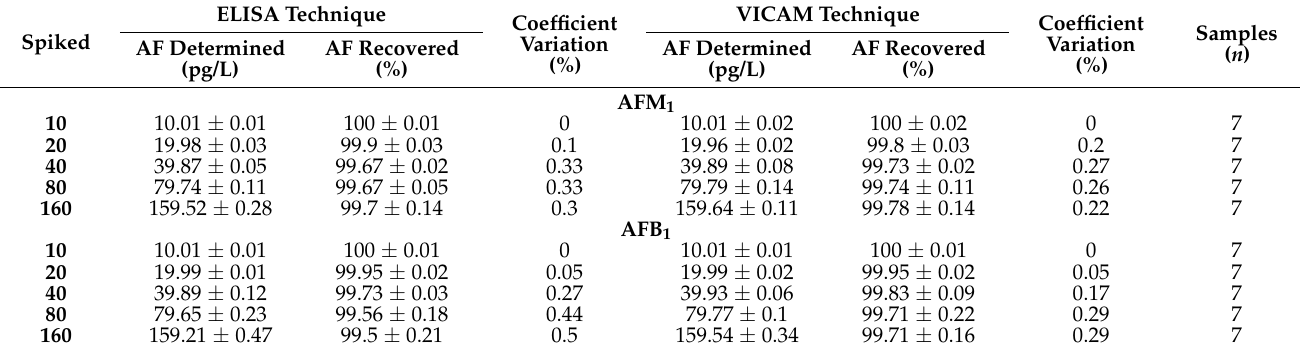
Table 3. Data validation for the samples using VICAM and ELISA techniques to determine AFM 1 and AFB 1